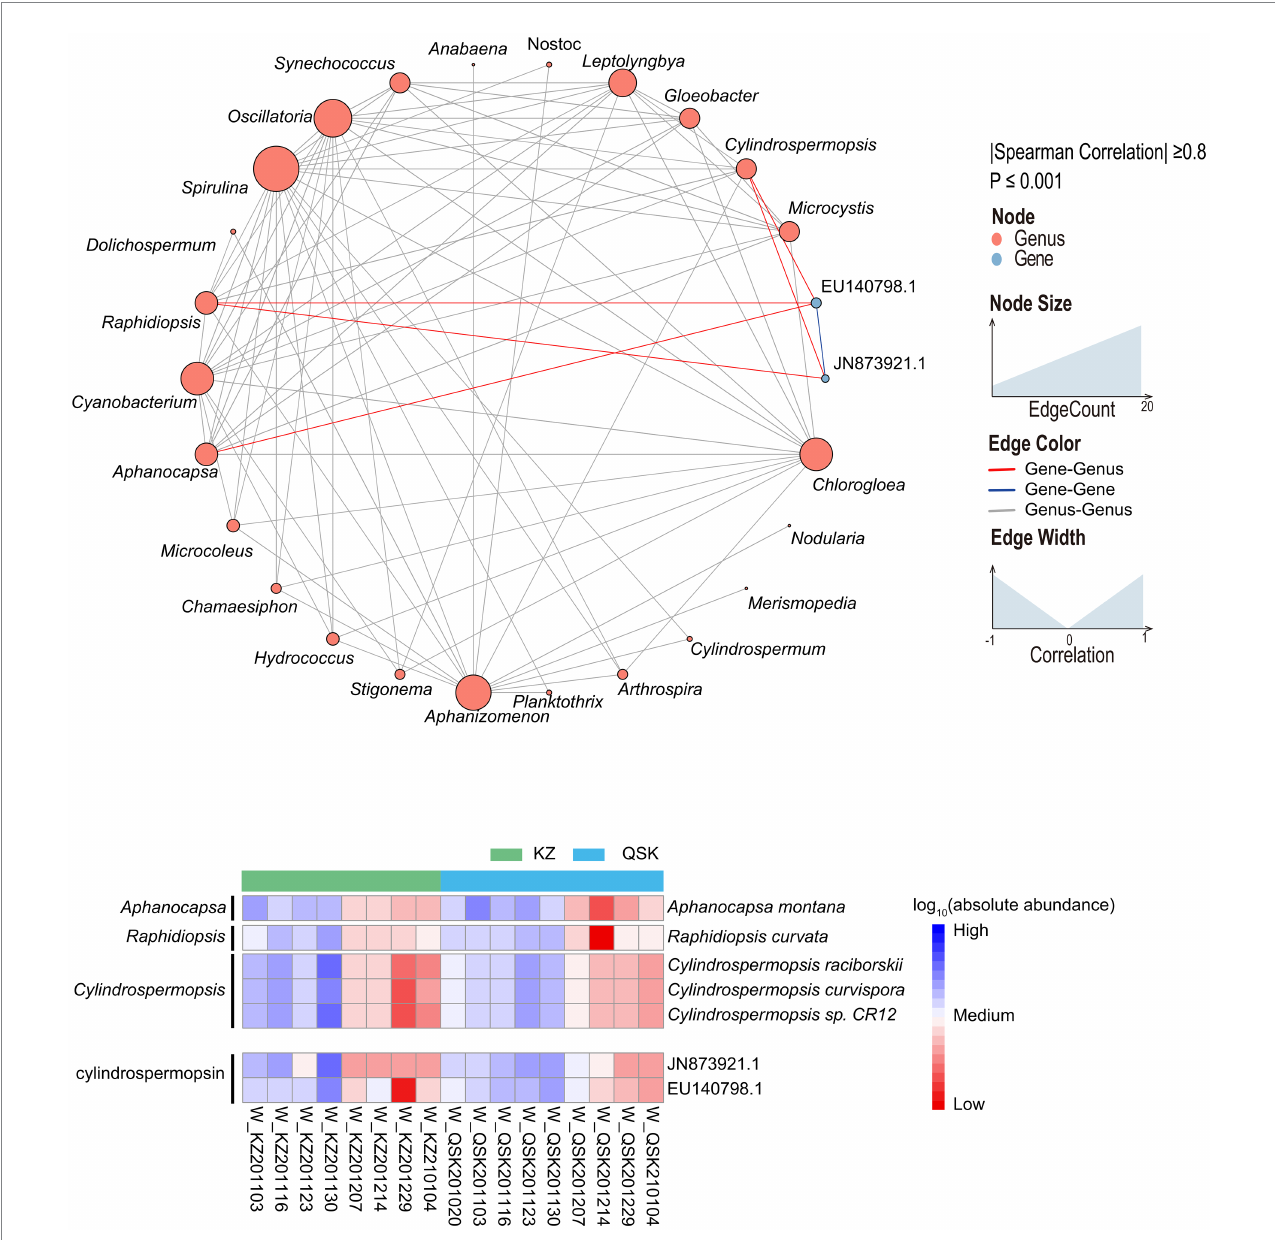
FIGURE 7 Cross-genus co-occurrence network of phycotoxin gene clusters in water samples. Network analysis coloring based on taxonomic genus preference. Associations indicated a significant ( p < 0.001), scored as positive (spearman’s p > 0.8). The size of each node is proportional to the SAV degree; the thickness of the connection between two nodes is proportional to the value of the Spearman correlation coefficient. Heatmap of the relative abundances of algal toxin gene clusters in all